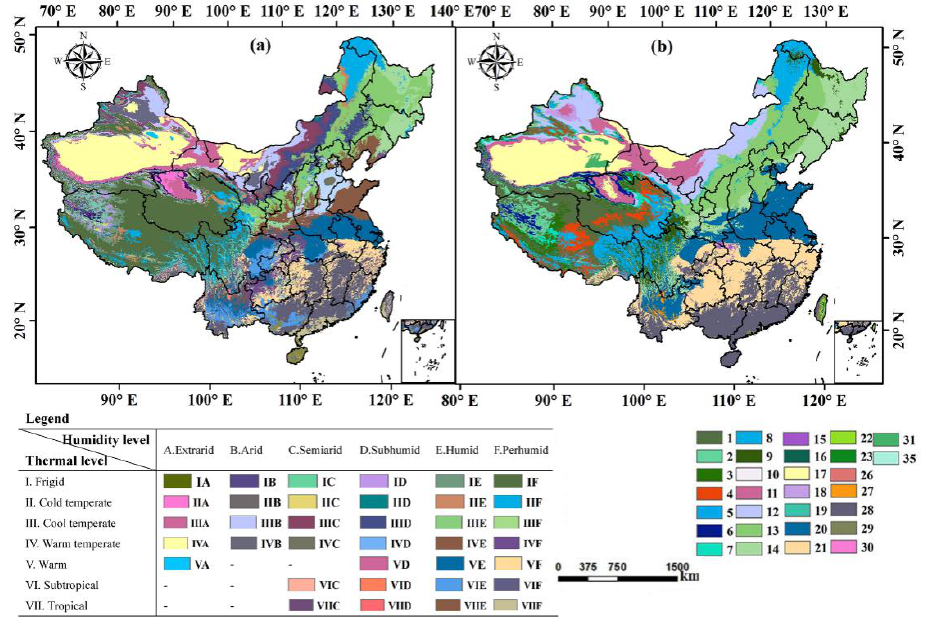
Figure 7. Comparisons of the vegetation maps of China based on CSCS model ( a ) and HLZ model ( b ).